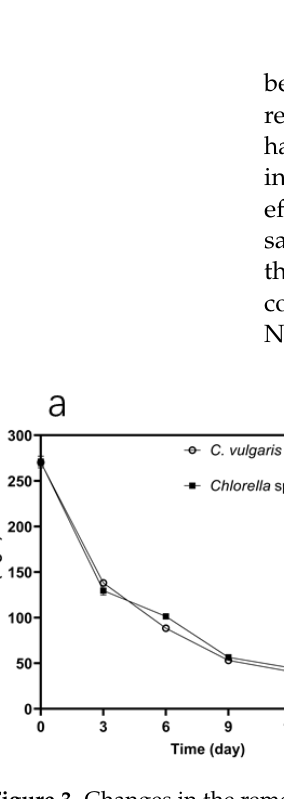
Figure 3. Changes in the removal of TN ( a ), TP ( b ), and NH 4+ -N ( c ) with time by FACHB-8 and FACHB-31 in undiluted ADSW within 15 days. Error bars represent SD ( n = 3).